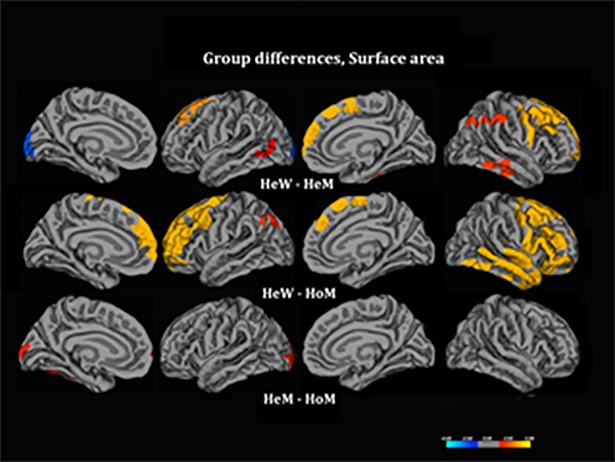
Group comparisons for surface area.The contrasts were calculated at p < .05, corrected for multiple comparisons (Monte Carlo permutation), using age as the covariate of no interest. The projection of cerebral hemispheres (MR images of the FreeSurfer atlas) is standardized. Scale is logarithmic and shows–log10(P), with cool colors indicating negative contrast, warm colors positive contrast. The two smaller images at the bottom illustrate Cth in HeM-HoM (left) and HeW–HoM (right) calculated without Monte Carlo correction; they were added to illustrate the HoM differed from both control groups in a similar manner.